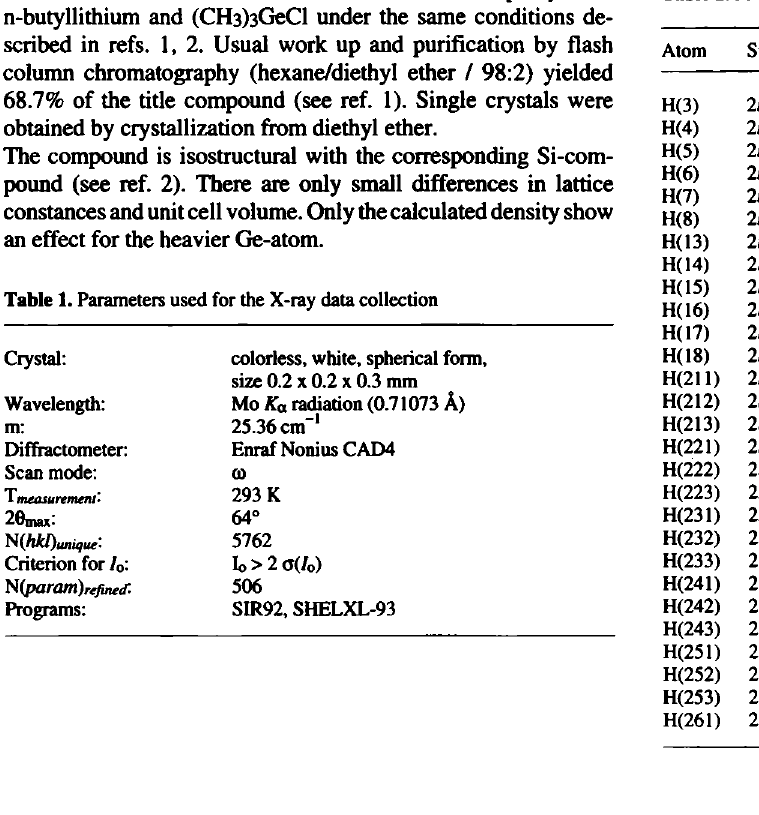
Table 2. Final atomic coordinates and displacement parameters (in Â 2